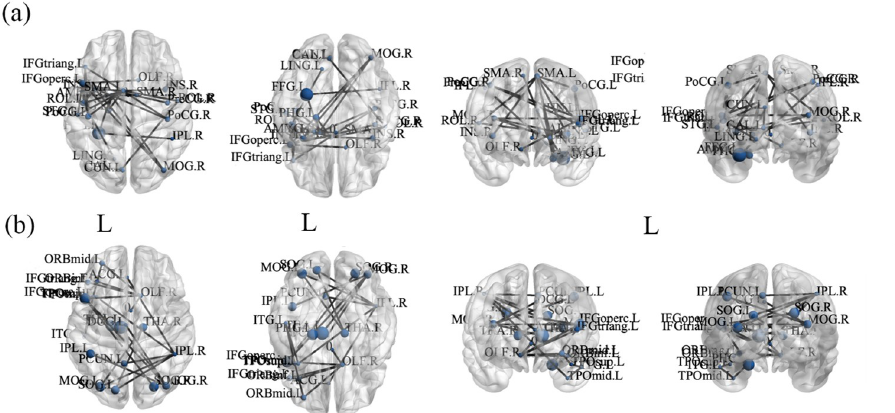
Fig 5. NBS results. (a) C+ group displayed significantly stronger subnetwork connections from the frontoparietal lobe to the subcortical nucleus and occipital lobe than did C- group (p = 0.05). (b) Although without statistical significance (p = 0.09), the HC group also showed stronger subnetwork connections on frontal, temporal, and occipital lobes than did the C- group.